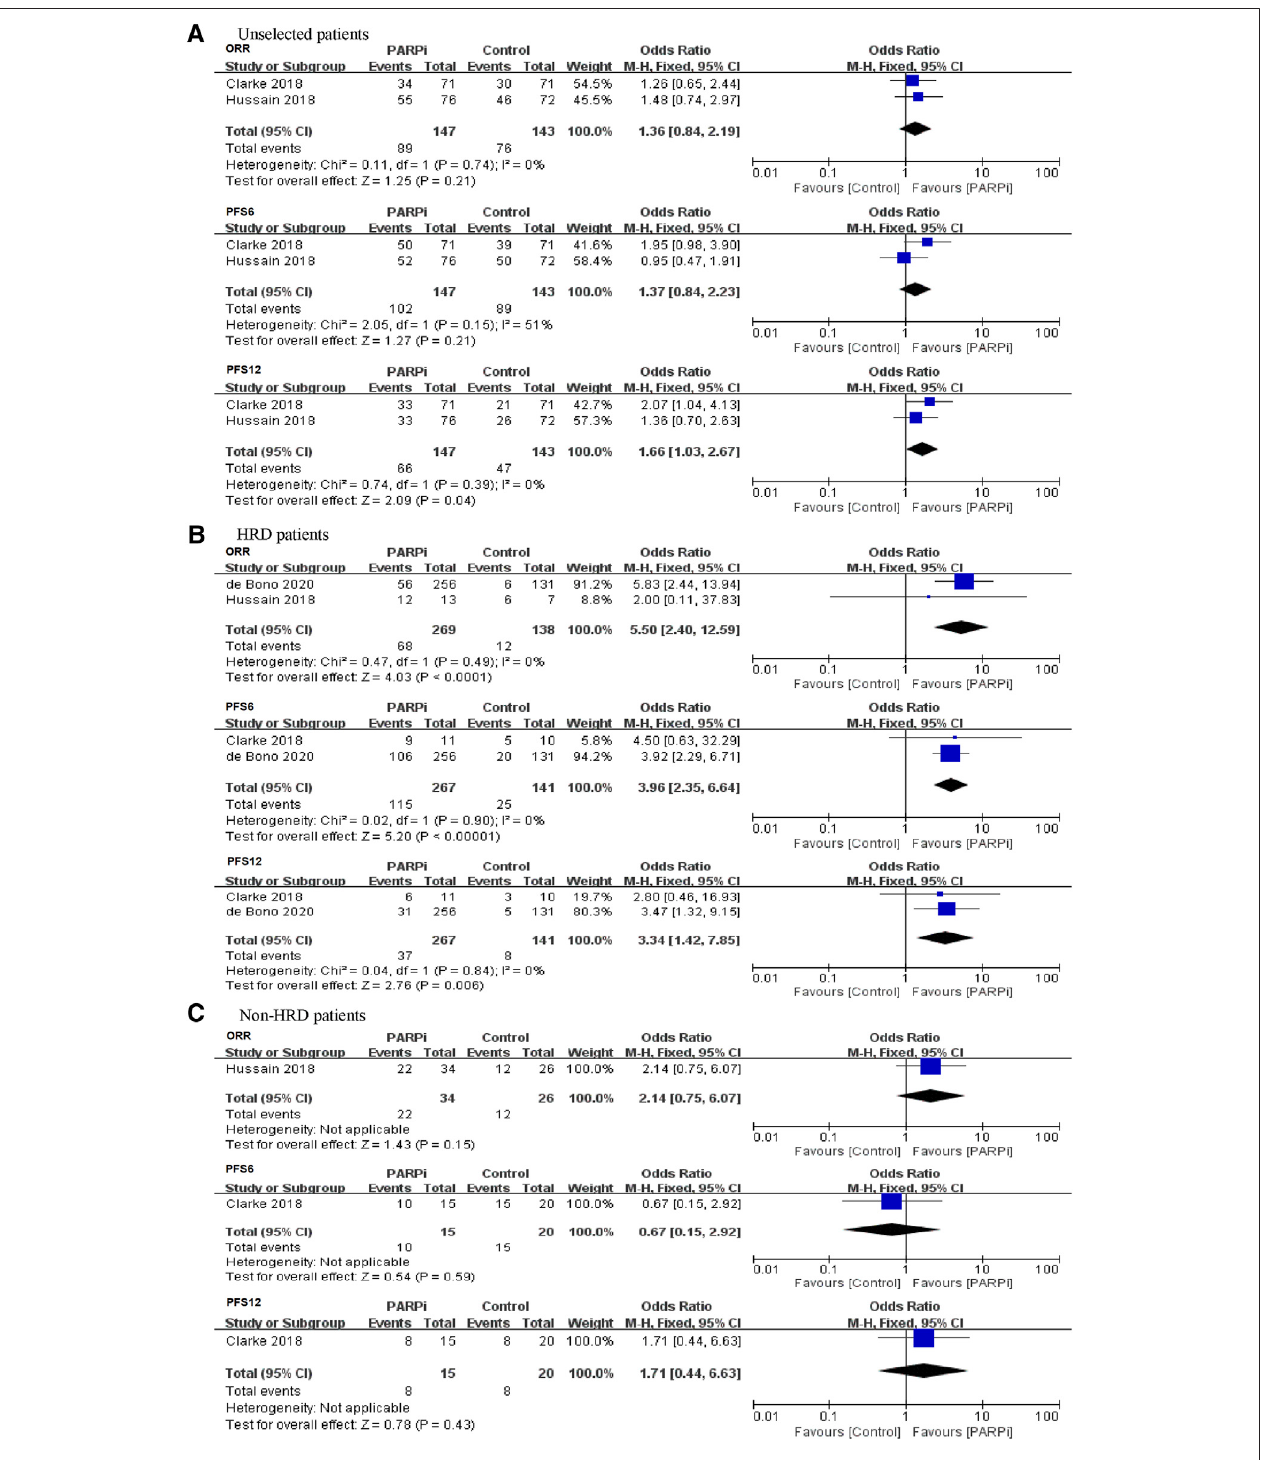
FIGURE 2 | Forest plots of pooled analyses for poly(ADP-ribose) polymerase inhibitors (PARPi) vs. control treatments on overall response rate (ORR) and progression-free survival (PFS) in (A) unselected patients, (B) homologous recombination de fi ciency (HRD) patients, and (C) non-HRD patients.